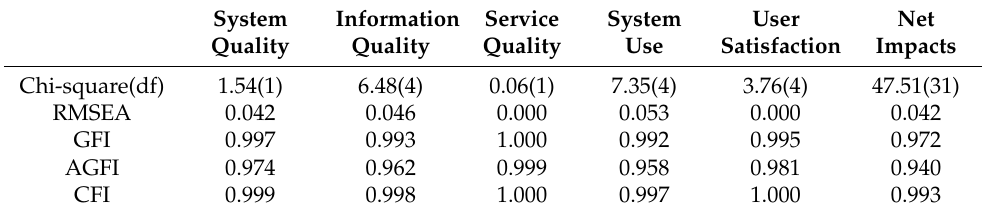
Table 5. Measurement model fit indices.